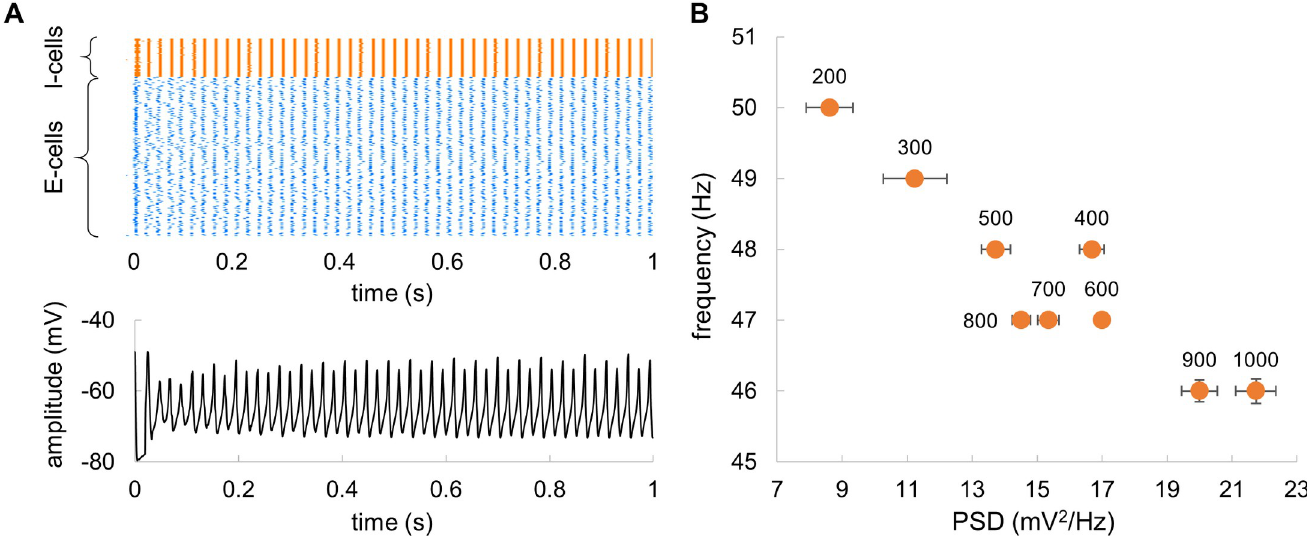
Fig 7. (A) Transients in spiking activity and average membrane potential after applying constant input currents to E-cells and I-cells. (B) The power (at the spectral peak) and corresponding frequency of the network as a function of the network size. The labels indicate the number of neurons in the network. Bars indicate standard deviation estimated in 20